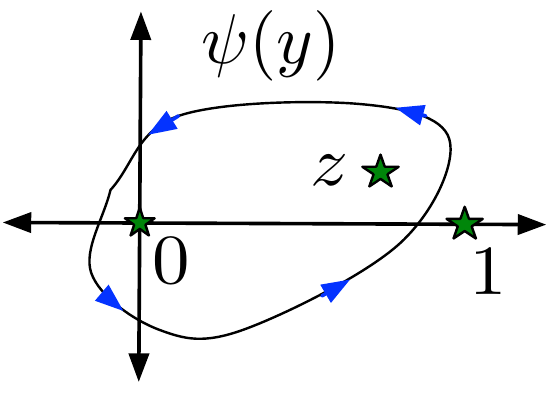
Figure 3 . The path along which we must translate ( y ), the solutions to equation (2.2), in order to de(cid:12)ne a 2 2 monodromy matrix. The path must encircle y = 0 and y = z , but not y = 1. (cid:2) block , holding the key not only to the leading semiclassical behavior but also to V